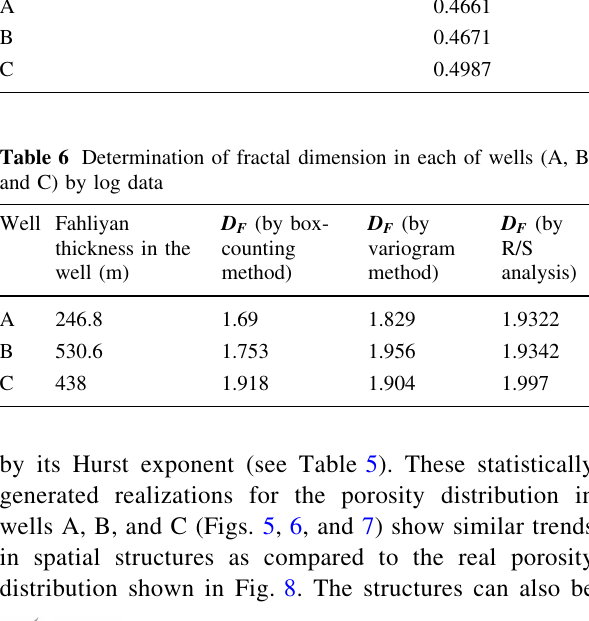
Table 5 Hurst exponents in each of wells (A, B, and C) Well